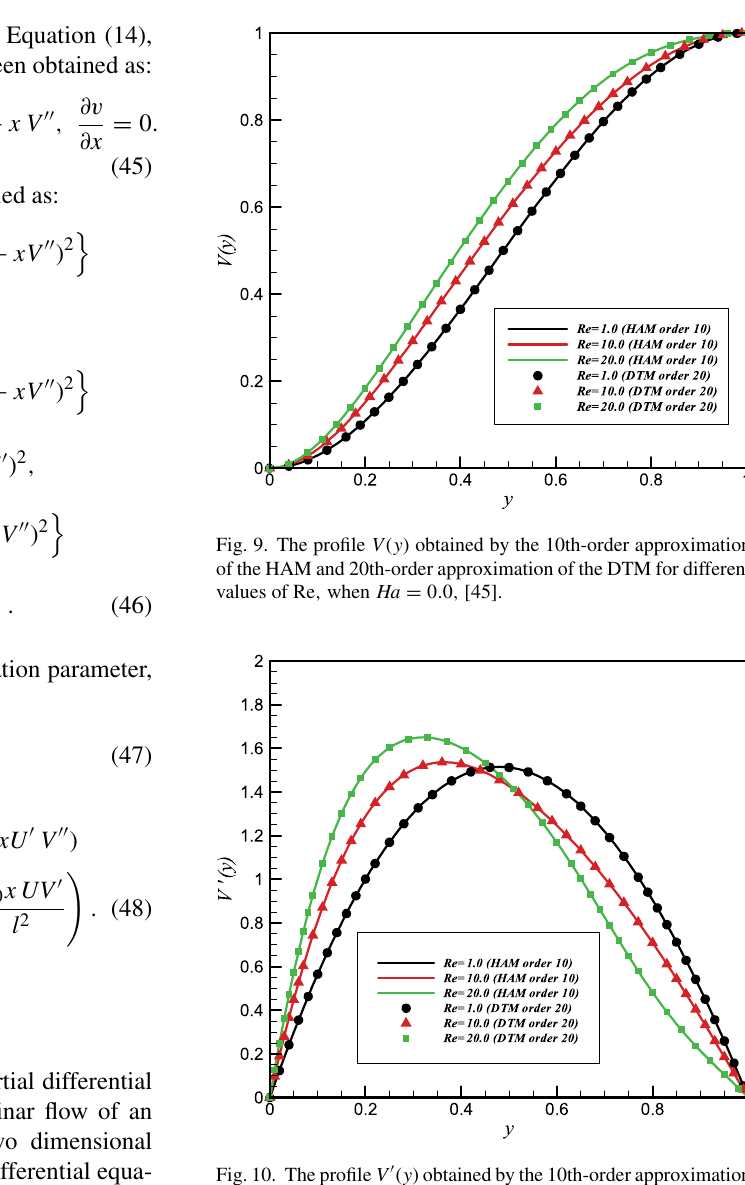
Fig. 10. The profile V (cid:2) ( y ) obtained by the 10th-order approximation of the HAM and 20th-order approximation of the DTM for different values of Re , when Ha = 0 . 0 ,